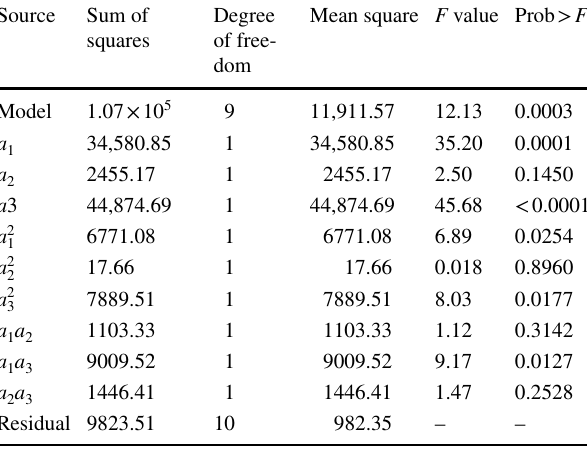
Fig. 2 Relationship between predicted and experimental data